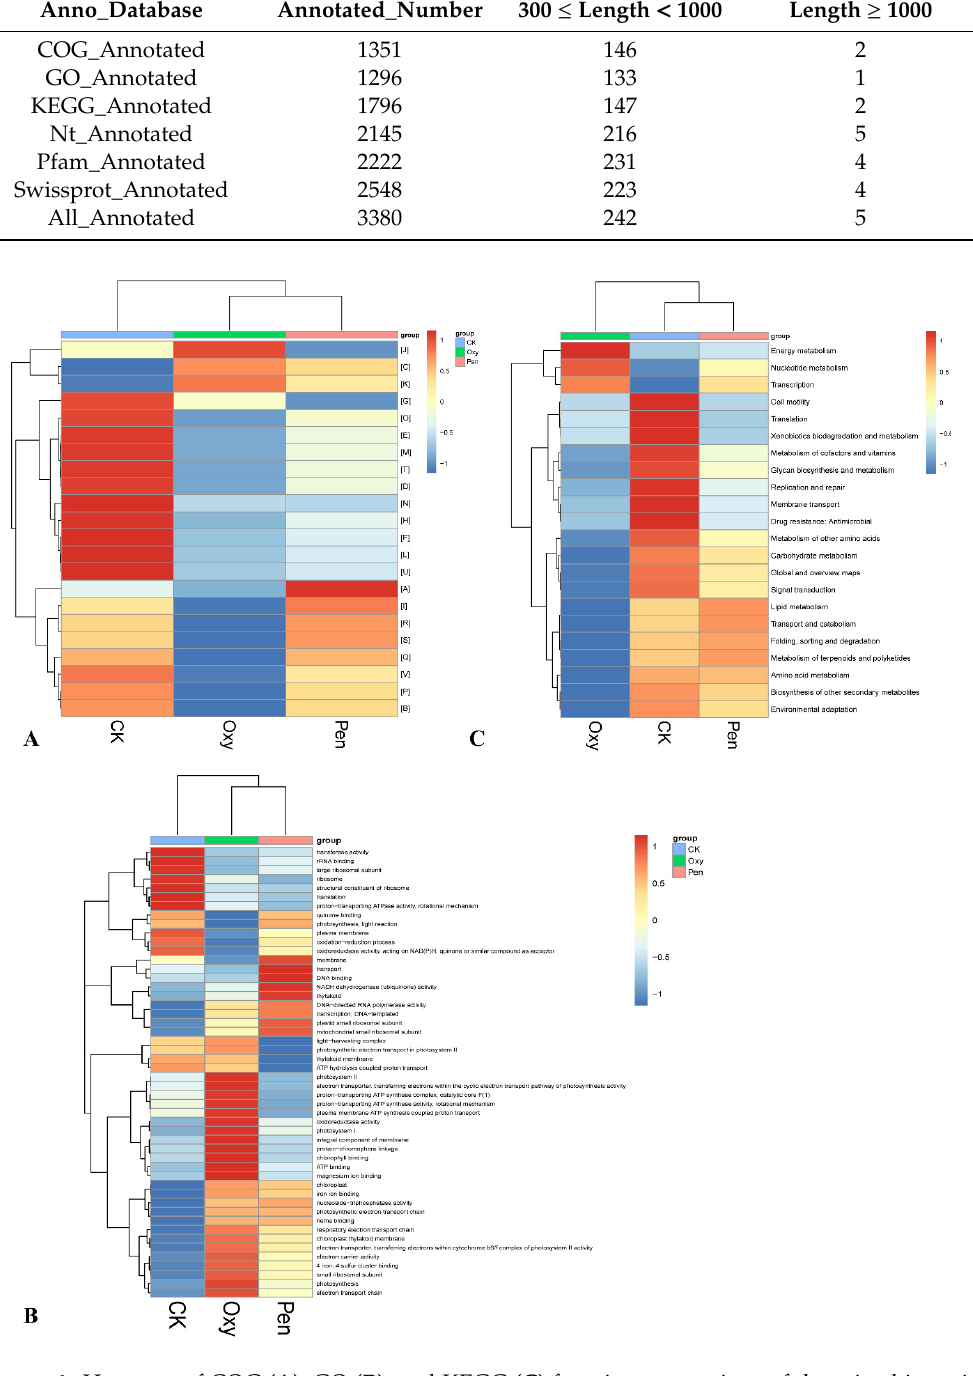
Figure 4. Heatmap of COG (A) , GO (B) , and KEGG (C) function comparison of the microbiome in HLB-affected citrus in response to oxytetracycline (Oxy) and penicillin (Pen) treatment.